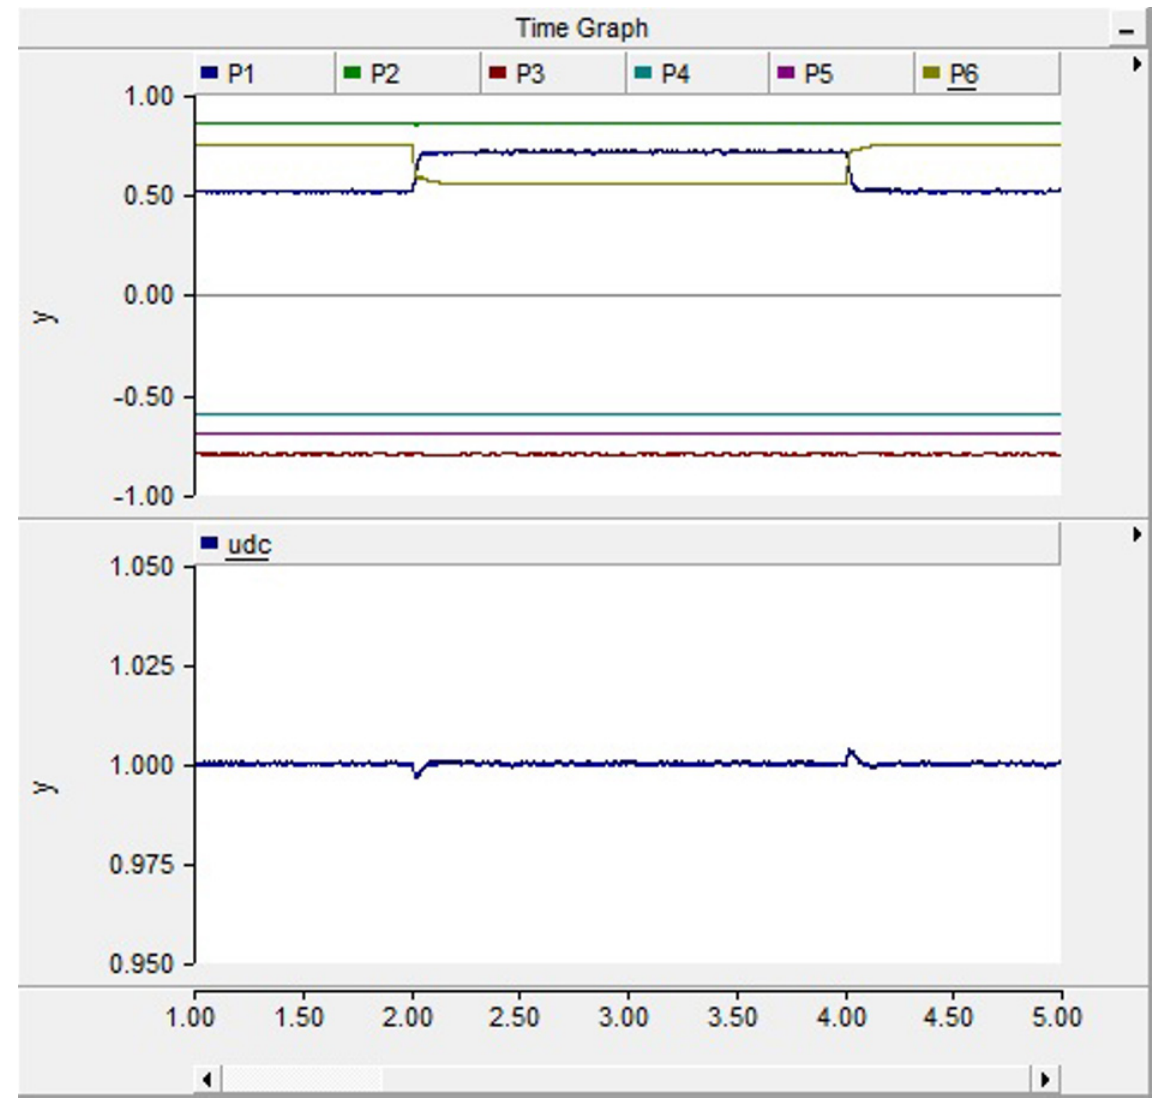
Figure 10. Responses when PV power changes